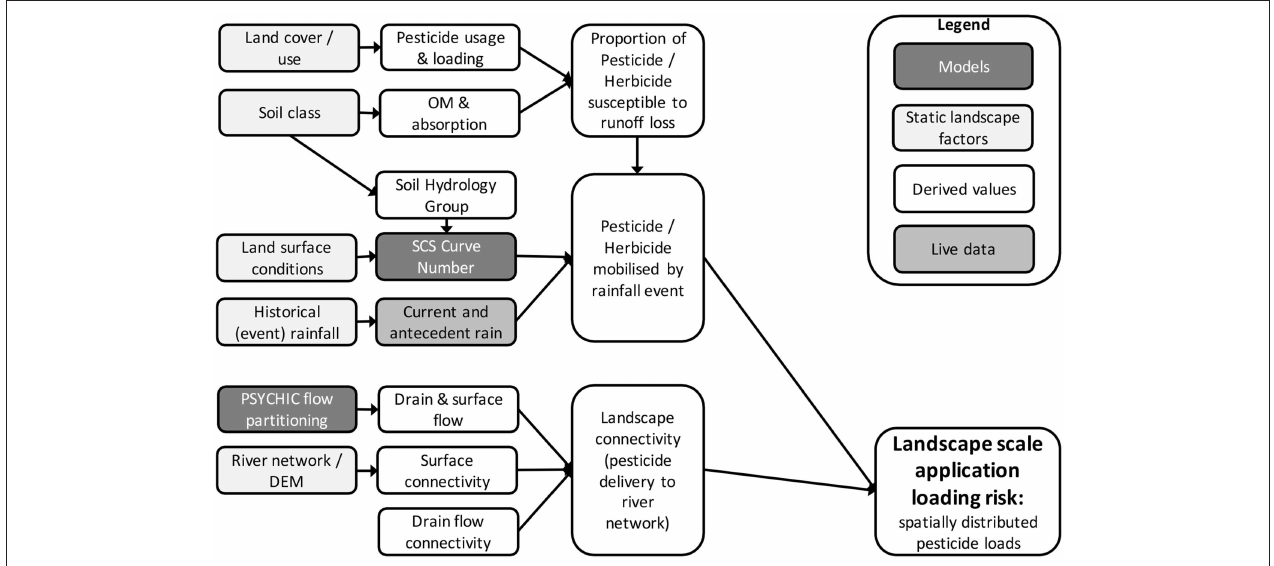
FIGURE 2 | The parsimonious landscape scale model. OM, organic